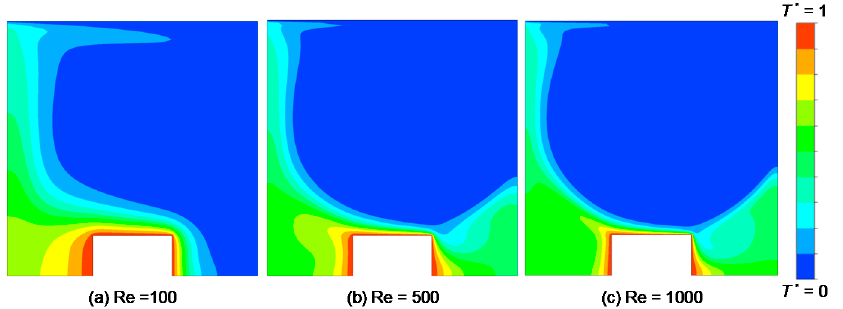
Figure 12. Dimensionless thermal contours for three different Reynolds number for H 1 / L 1 = 0.5 and Ra = 10 5 for the fin area fraction of 0.05 and an Al 2 O 3 -volume fraction of 1%. ( a ) Re = 100; ( b ) Re = 500; ( c ) Re = 1000.